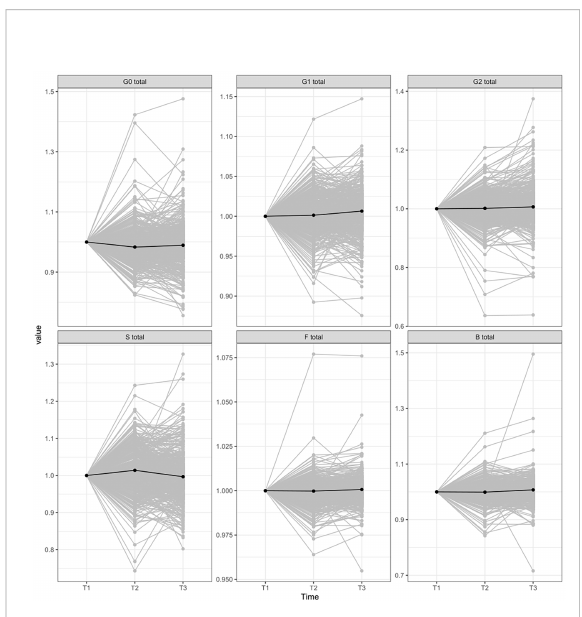
FIGURE 2 IgG glycome composition changes between different time- periods normalized to the fi rst point. T1, time point 1; T2, time point 2; T3, time point 3; G0, agalactosylated glycans; G1, monogalactosylated glycan structures; G2, glycans with two galactoses; S, glycans containing sialic acid; F, glycans with core fucose; B, glycans with bisecting